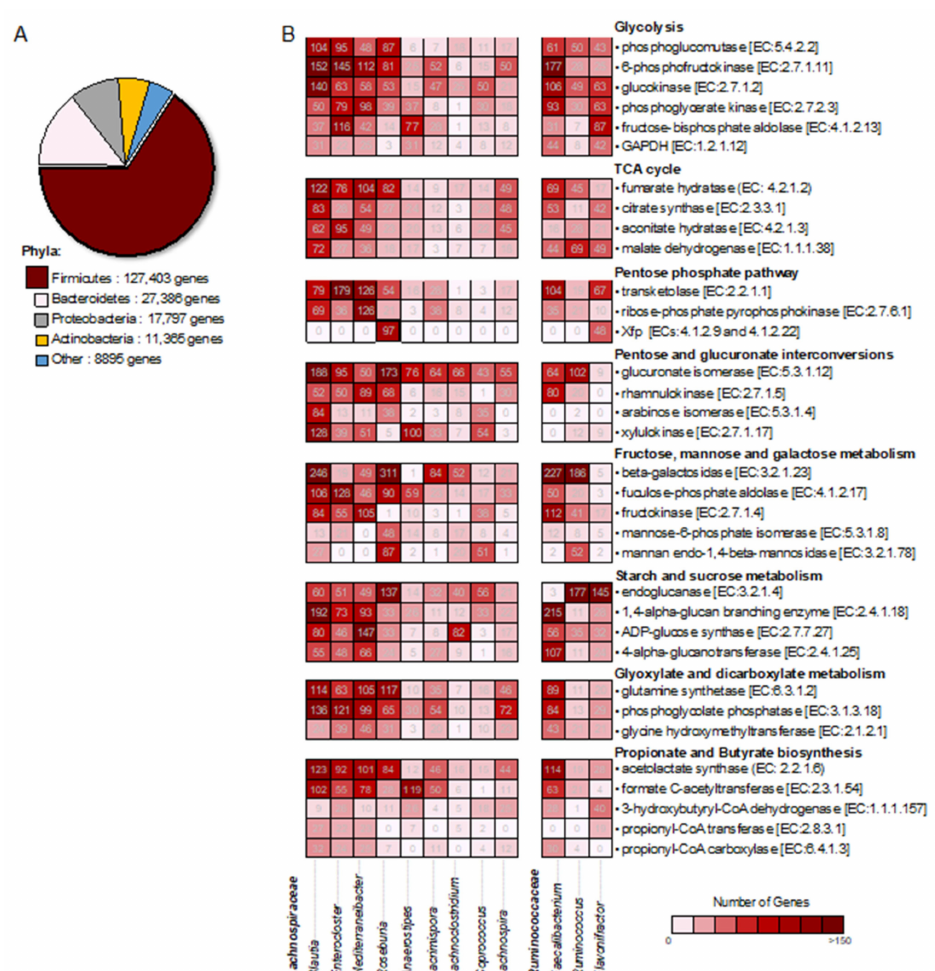
Figure 4. Bacterial community-wide metabolic functional analysis involved in carbohydrate metabolism. ( A ) Total number of genes involved in carbohydrate metabolism across the differ- ent phyla, and ( B ) Distribution of genes involved in metabolic functions and pathways involved in carbohydrate metabolism across taxonomic profile of bacterial community. Abbreviated en- zyme names are as follows: GAPDH, glyceraldehyde 3-phosphate dehydrogenase; Xfp xylulose-5- phosphate/fructose-6-phosphate